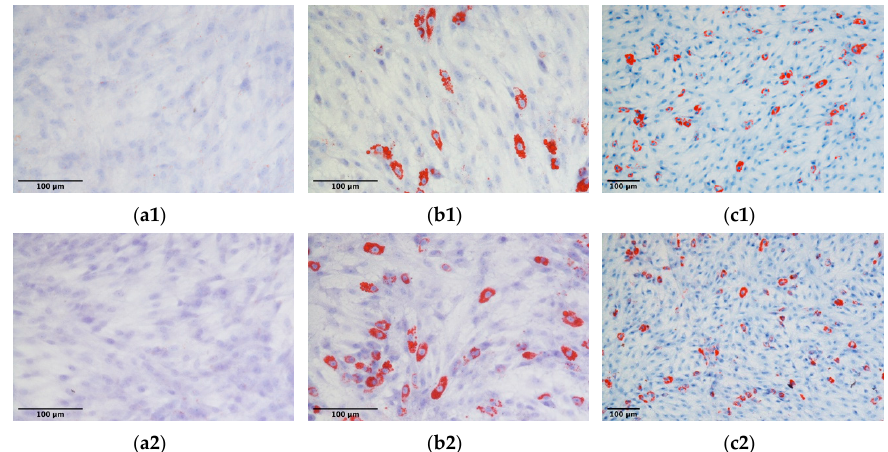
Figure 12 . Adipogenic differentiation of ADMSCs: ADMSCs expanded on plastic ( b1 , c1 ) or inside the 3D fibrin-based matrix ( b2 , c2 ) were positive to Red Oil O staining after stimulation with adipogenic differentiation medium. Control unstimulated cells ( a1 , a2 ) did not accumulate lipid droplets.